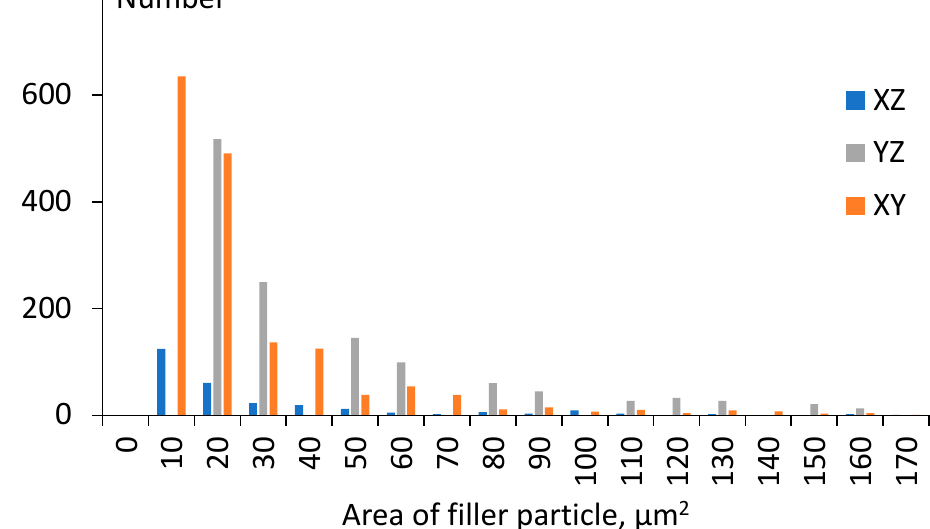
Figure 7. Filler particle’s area distribution for the samples printed in different directions (indicated on the graph).